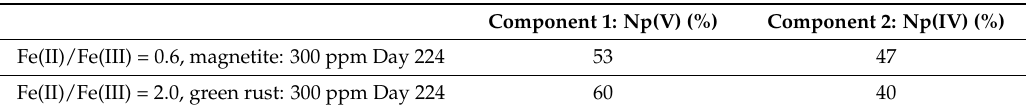
Table 1. Linear combination fitting results for XANES samples Fe(II)/Fe(III) = 0.6 and Fe(II)/Fe(III) = 2.0 at 300 ppm after oxidation. Fitting was performed using a Np(V) ferrihydrite standard [19] and the Fe(II)/Fe(III) = 0.6, 300 ppm sample before oxidation for Np(IV). Component 1: Np(V)